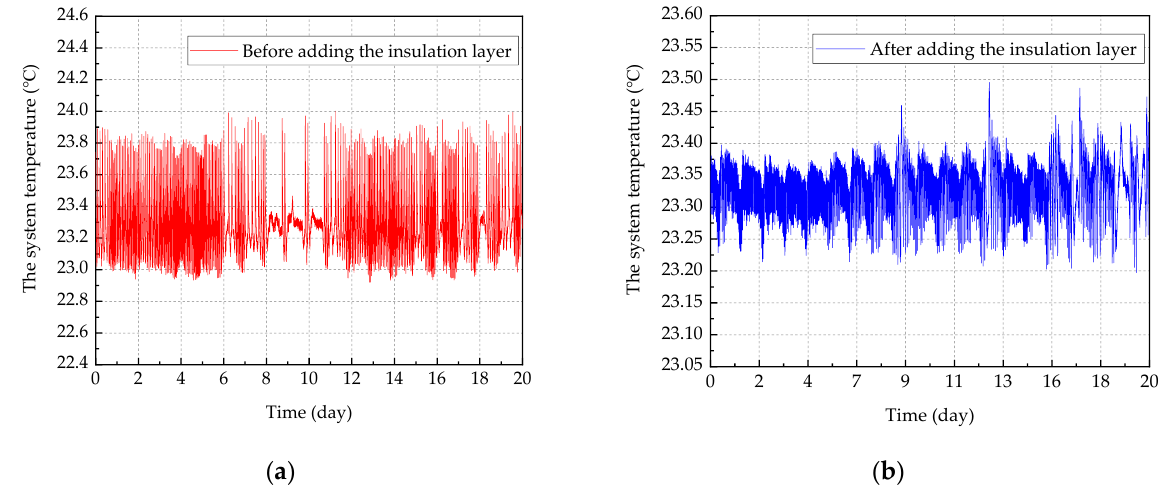
Figure 3. Physical system temperature measurement: ( a ) before adding the insulation layer; ( b ) after adding the insulation layer.